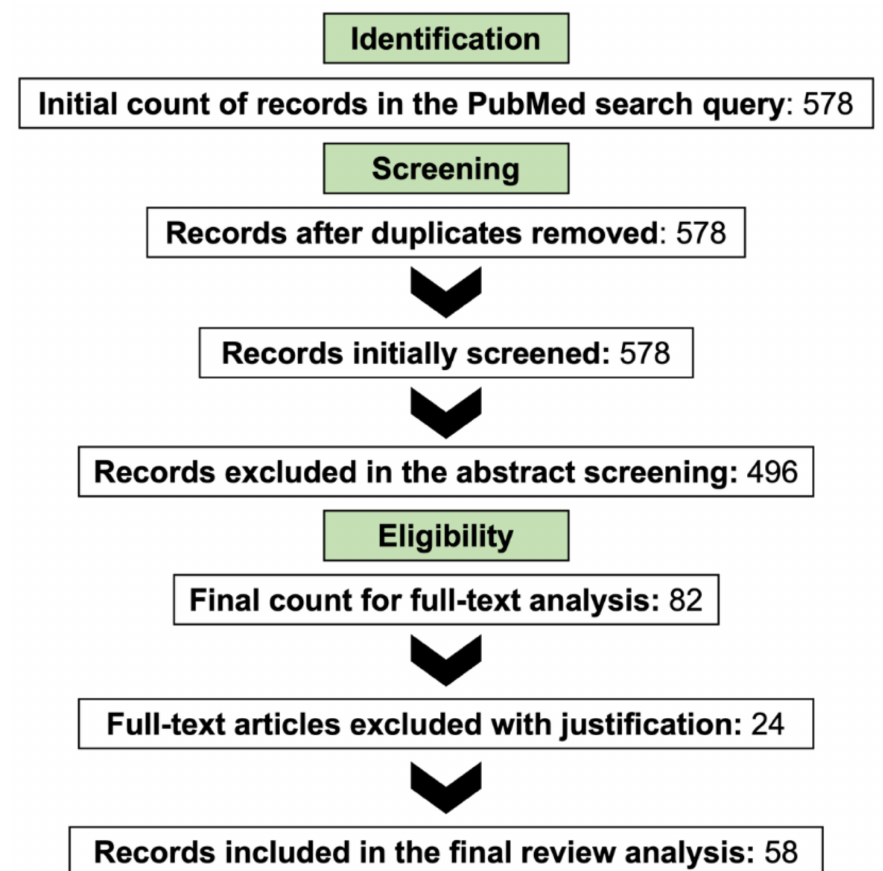
Figure 2. The research methodology employed for this